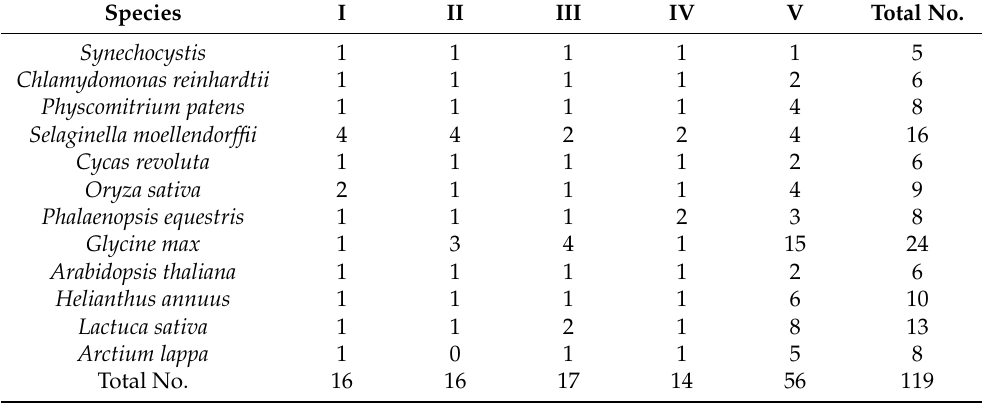
Table 1. Classification of UBiA family